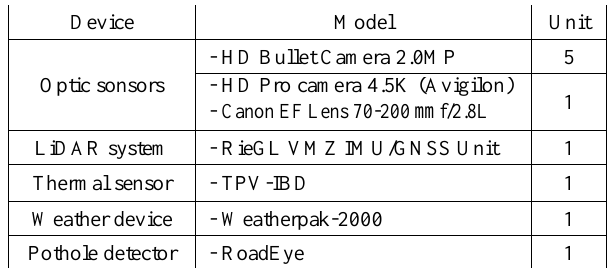
Table 1. Sensors mounted on investigation vehicle of NDMI